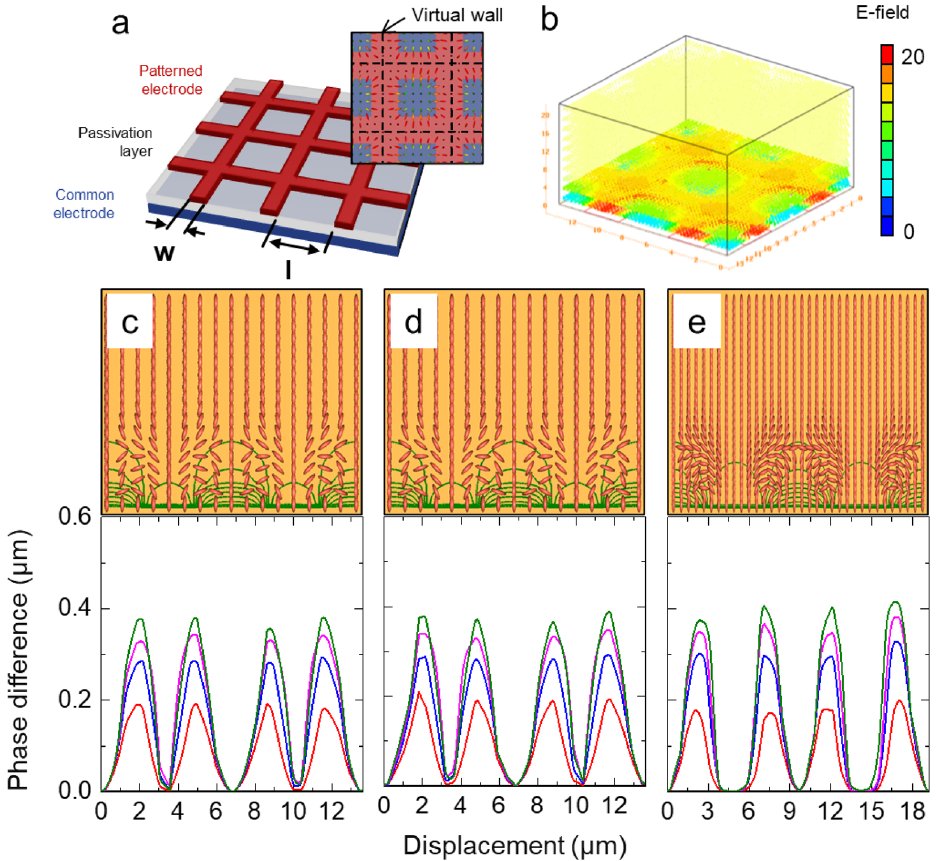
Figure 1. Proposed LC grating cell. ( a ) Cell structure and top-view of LC director configurations. ( b ) E-field distribution (20 V). Calculated LC director distributions and phase difference profiles in ( c ) x -direction, ( d ) y -direction, and ( e ) diagonal